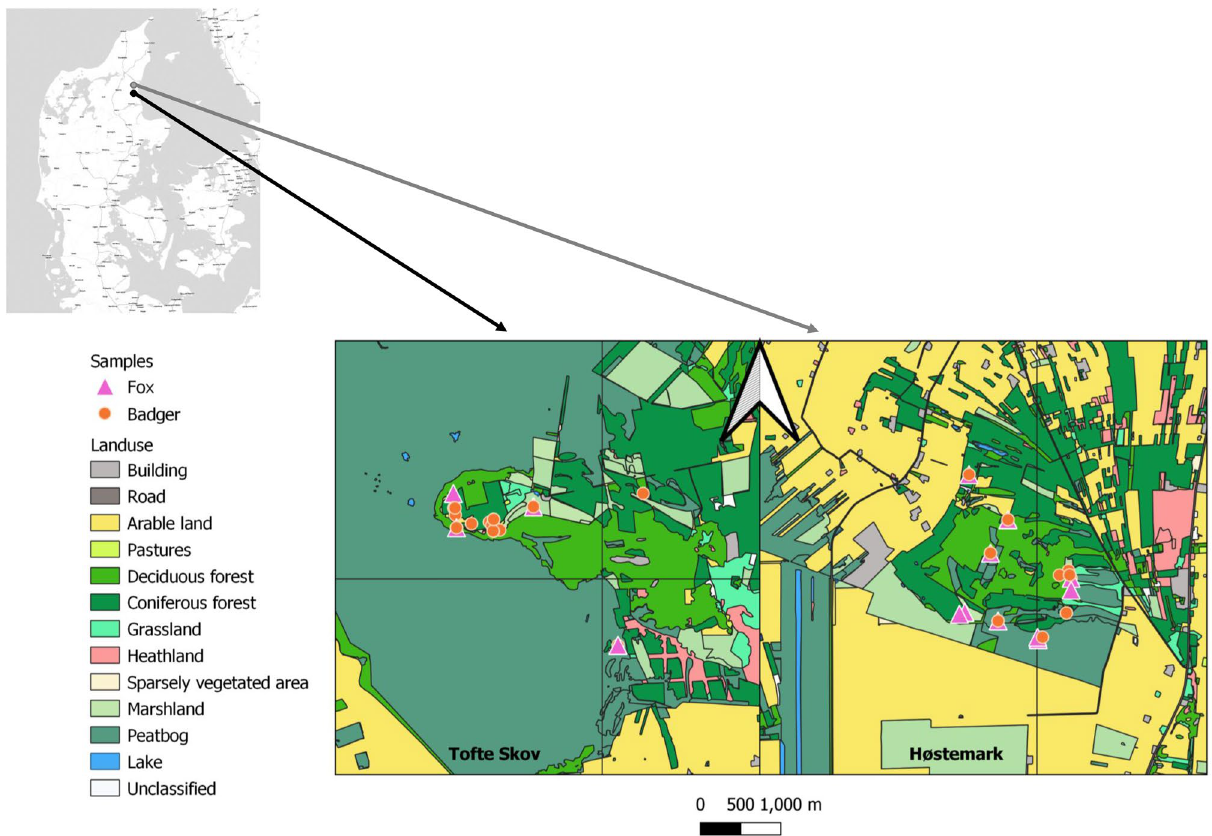
Figure 1. Location of the sampling area, Lille Vildmose in Denmark. Høstemark skov (grey dot in top left corner) and Tofte Skov (black dot in top left corner). Maps were created using qGIS ver. 3.16 (https:// www. qgis. ord/ en/